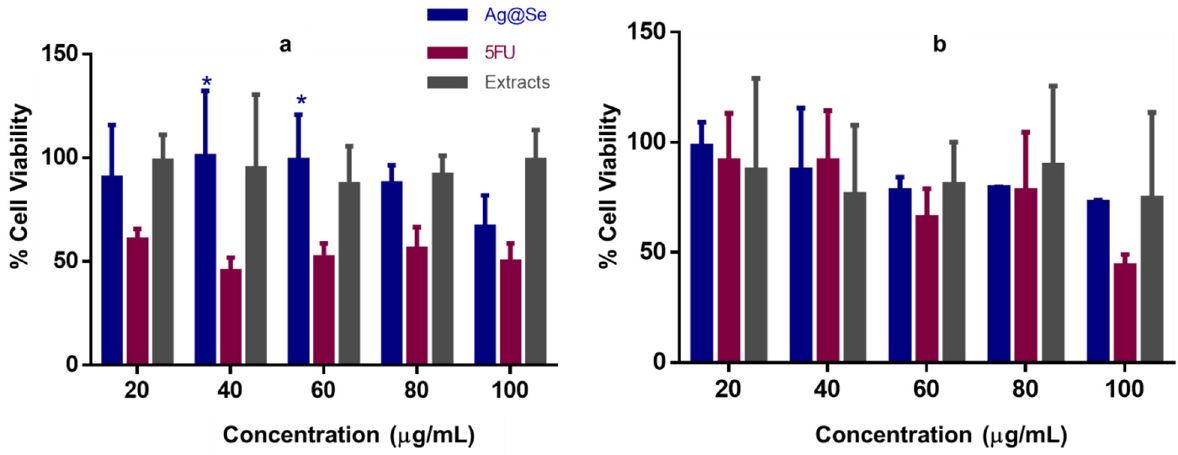
Figure 5. Cytotoxicity assay of Ag@Se NPs,5-FU and the plant extract in ( a ) HEK293 and ( b ) MCF-7 cells. Data are represented as mean percentage cell viability ± SD ( n = 3). * p < 0.05 when compared to the 5-FU